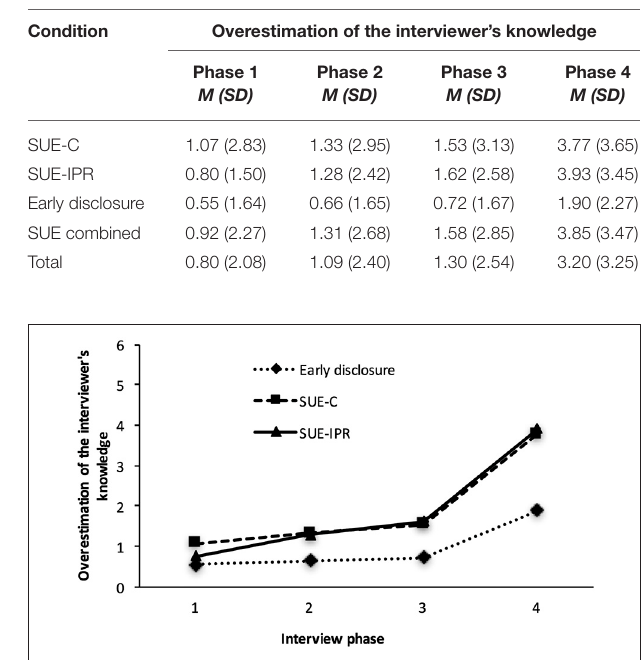
FIGURE 2 | The course of the suspects’ overestimations of the interviewer’s knowledge about the critical phase of the